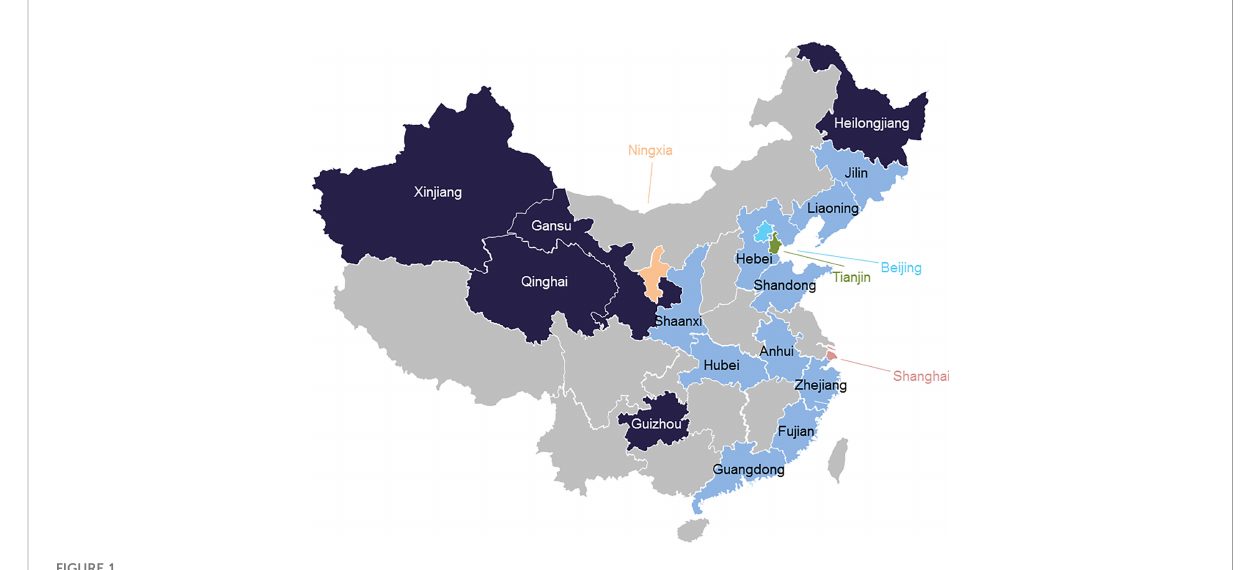
FIGURE 1 Location of sampling sites in